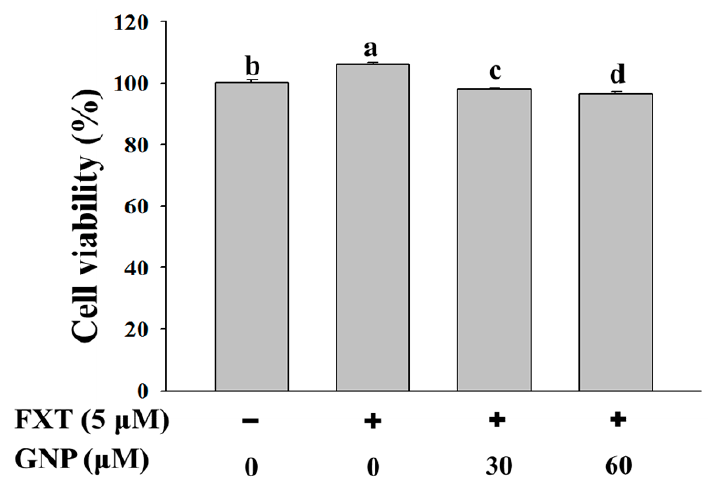
Figure 1. Effect of FXT-GNP on the cell viability of HepG2 cells. HepG2 cells were seeded onto a 6-well plate at 5 × 10 5 cells/mL and incubated overnight, then treated with FXT-GNP at dose as indicated and further incubated for 72 h. DMSO (0.1%) was used as the vehicle control. Values are expressed as mean ± SD ( n = 3). Different letters indicate statistical significance ( p < 0.05).